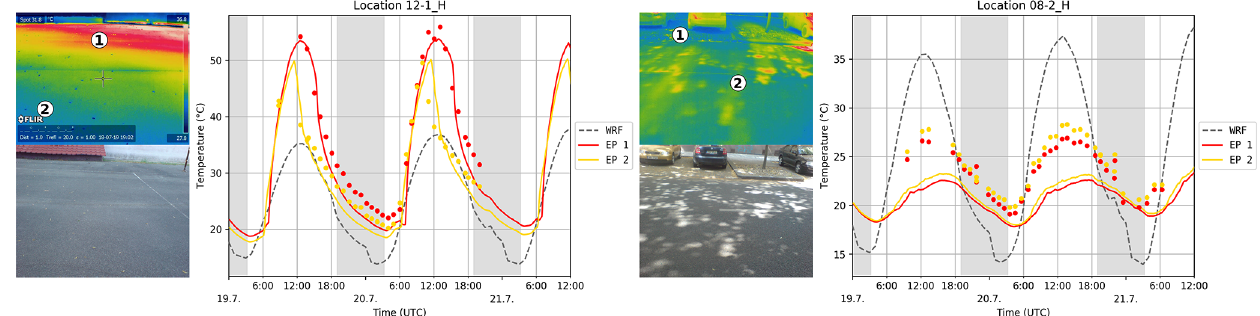
Figure 21. IR and RGB photos showing the locations of evaluation points, and the graph of the observed (dots) and modelled (lines) surface temperature for these evaluation points during the summer e2 episode (19–21 July 2018). The left half of the figure shows location 12-1_H (the asphalt playground in the courtyard of Sinkule house), and the right half of the figure shows location 08-2_H (asphalt concrete surface in Terronská Street). The grey dashed line shows the corresponding WRF skin layer temperature. The grey areas denote night-time.